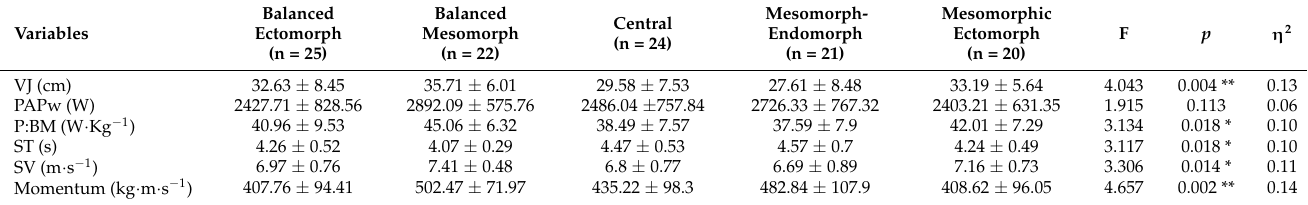
Table 4. Descriptive statistics (mean ± SD) for the jumping and sprinting variables in participants by dominant